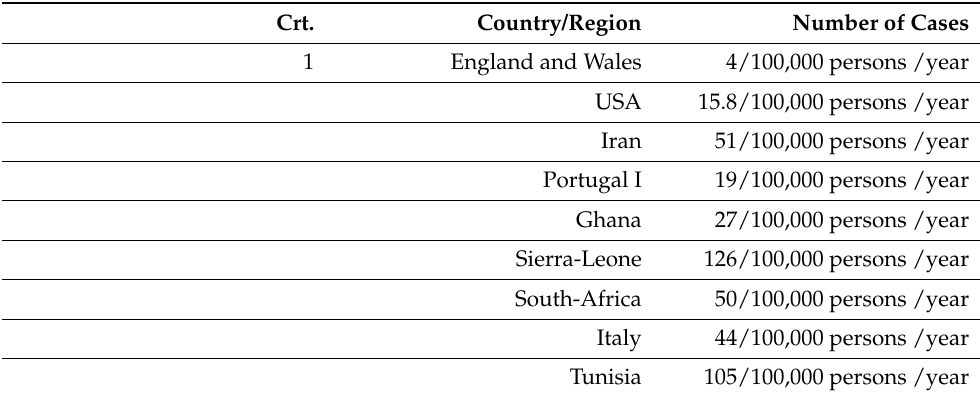
Table 4. Incidence of corrosive esophagitis according to different reports.